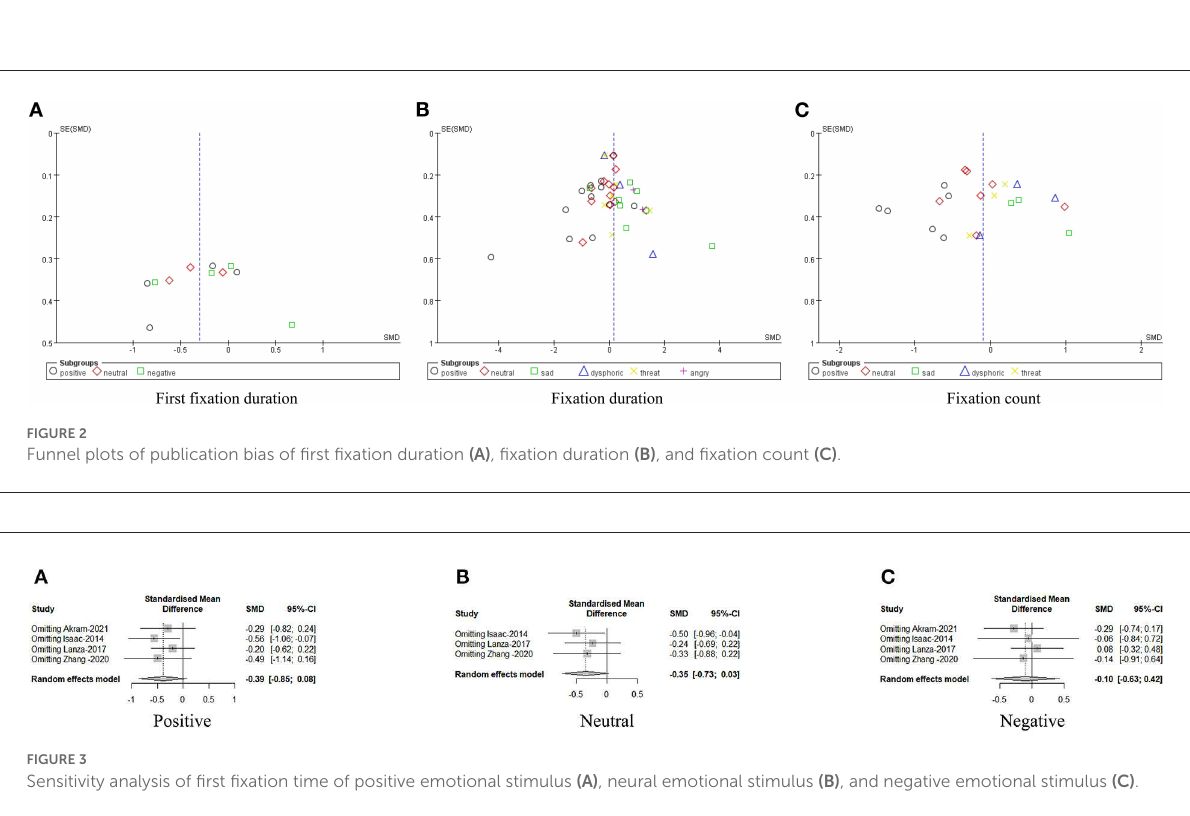
for positive emotional stimuli than healthy individuals (SMD = − 0.87, P = 0.004), whereas the fixation count for negative emotional stimuli was significantly higher in the depression group than in the healthy controls (SMD = 0.32, P =